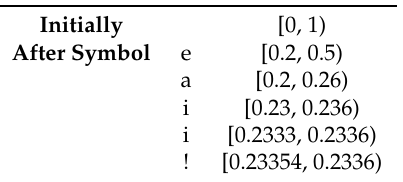
Table A2. Calculated ranges for all the